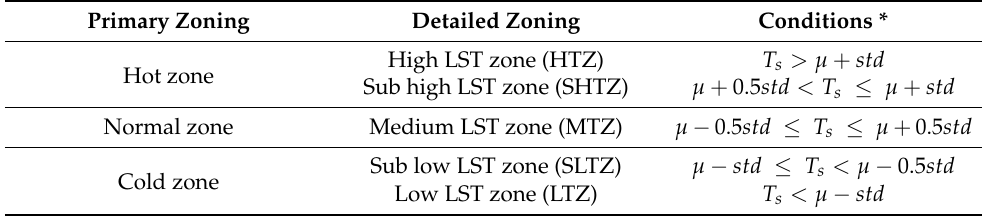
Table 2. Statistic basis of LST